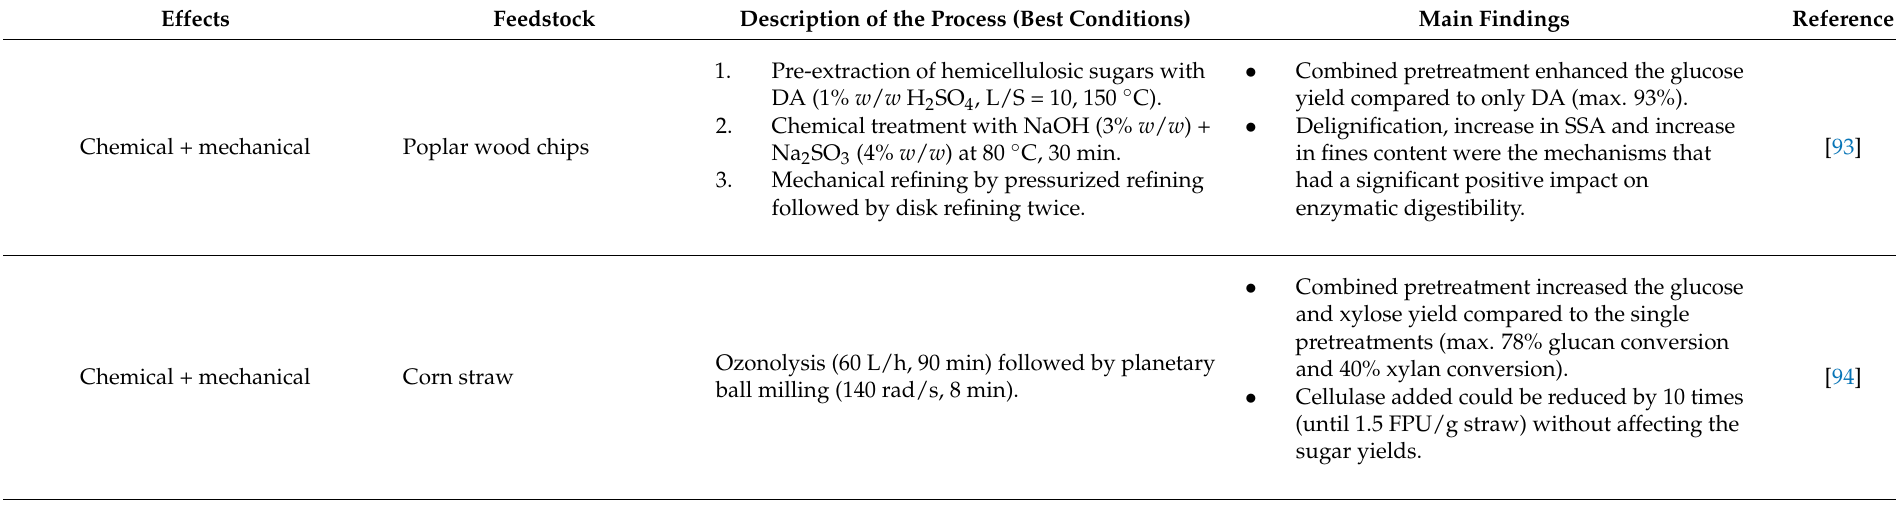
Table 2. Selected examples of hybrid methods used to pretreat different lignocellulosic